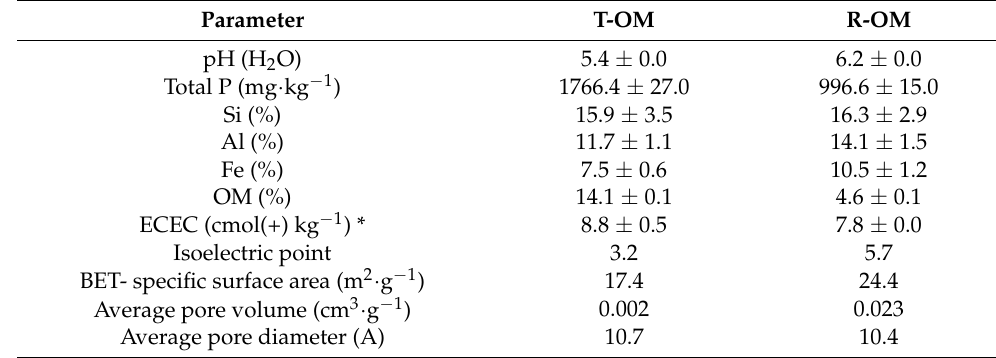
Table 3. Physico-chemical properties of soil with total organic matter (T-OM) and with partial removal of matter